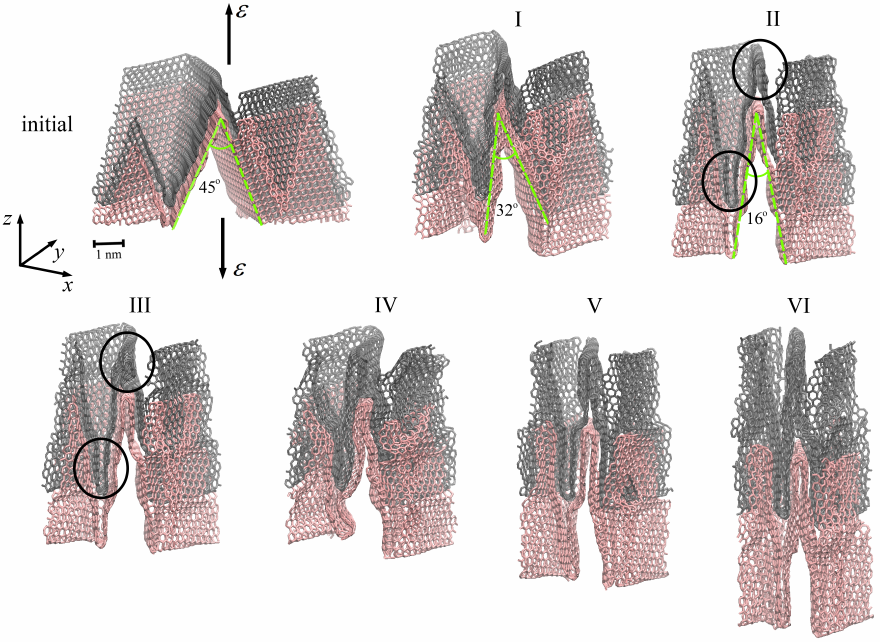
Figure 6. The snapshots of structures at critical points I ( ε = 0.56), II ( ε = 0.75), III ( ε = 0.85), IV ( ε = 1.0), V ( ε = 1.2) and VI ( ε = 1.5) during tension along the z -axis. The structure after compression and before tension is labeled as “initial”. Points I–VI are shown as a black solid line in Figure3. The tension directions are shown by black